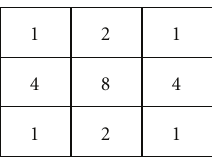
Figure 5: A simple visual attention model defined in [21].